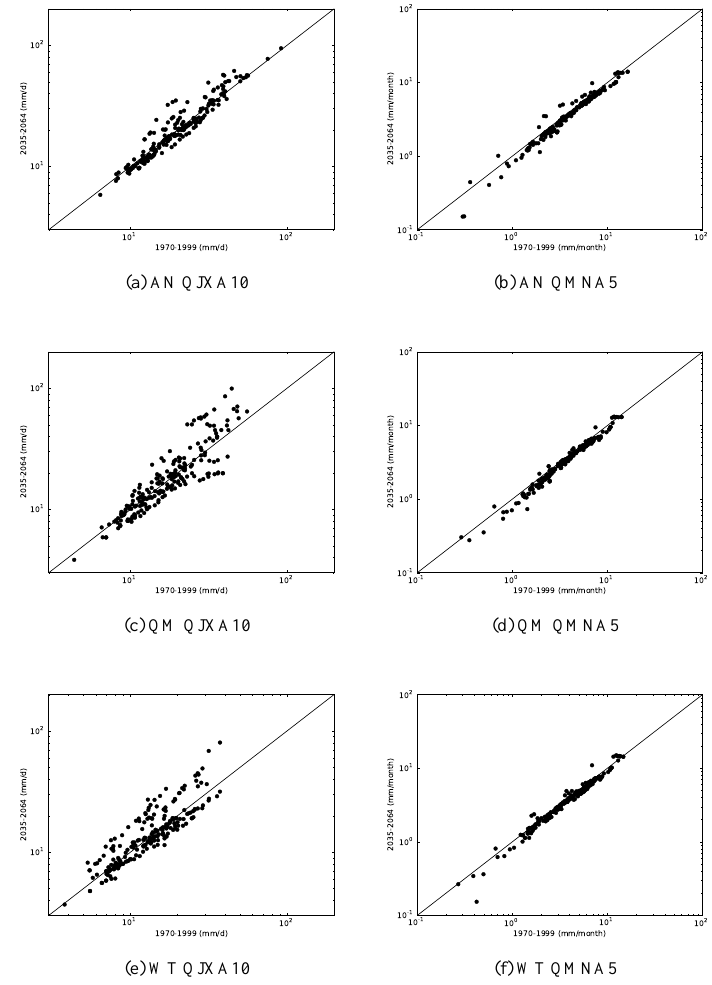
Fig. 12. Comparison of the past and future simulated QJXA10 and QMNA5 for the individual gauging stations.